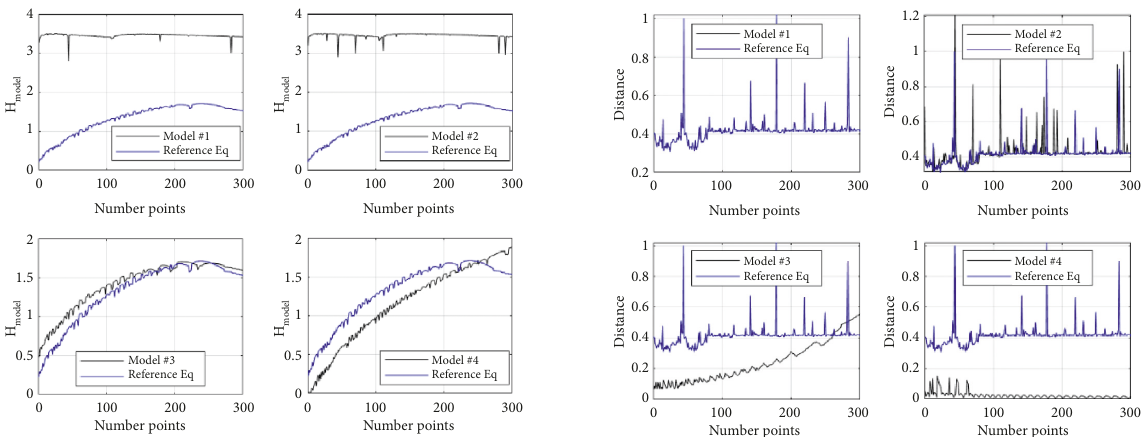
Figure 5: Plots of the entropy H and distance D for the models of Table 1 in Section